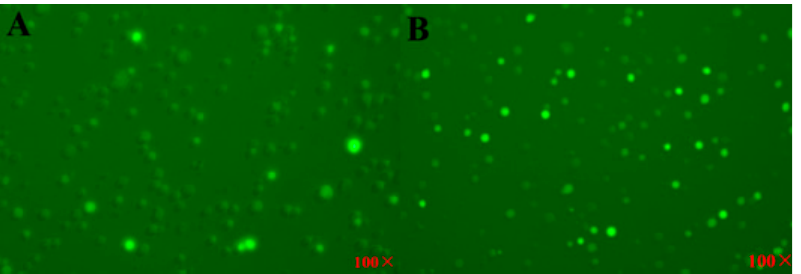
Figure 5. ROS staining of SU-DHL-2 cells: ( A ) control group; ( B ) treatment group, propolis at IC 50